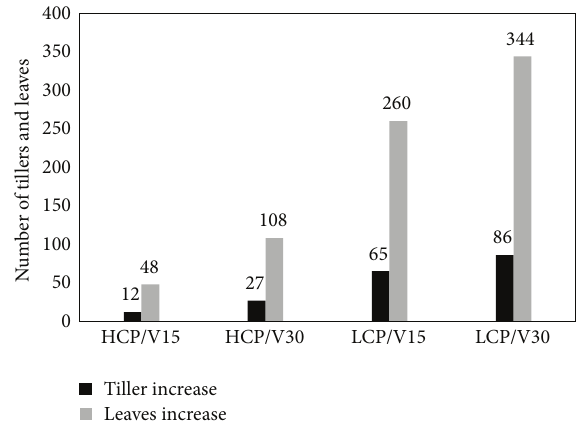
Figure 6: Root and shoot length of Vetiver (cm) (HCP is high concentration POME and LCP is low concentration POME).